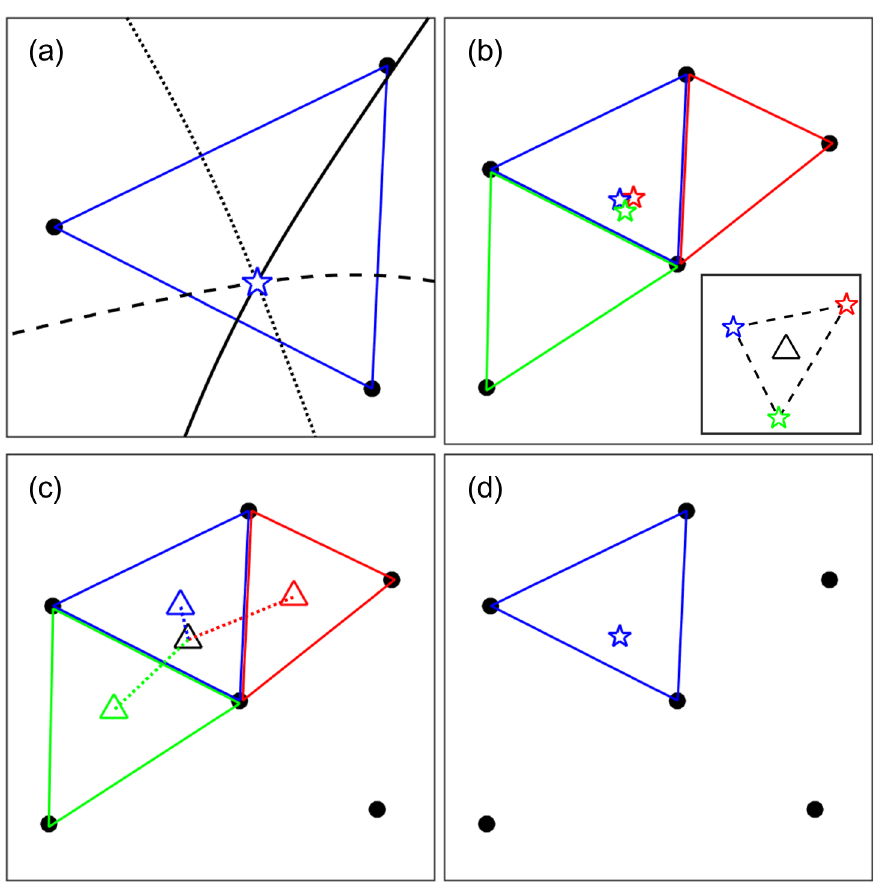
Fig 2. Example procedure of the proposed positioning method in this study. (a) A sound source position of a signal was horizontally estimated as an intersection (blue star) of three hyperbolae (bold, dashed, and dotted lines) by any subsets of close equilateral triangles. (b) When the signal was detected by five receivers forming three subsets (red, green, and blue triangles), three tentative estimates (red, green, and blue stars) were obtained by each subset. (c) Then, the distance between the centroid of three tentative estimates (small black triangle) and the three centroids of each subset (small red, green, and blue triangles) was calculated. (d) Finally, the estimated position by the blue triangle subset was selected for the final estimate using a criterion of the shortest